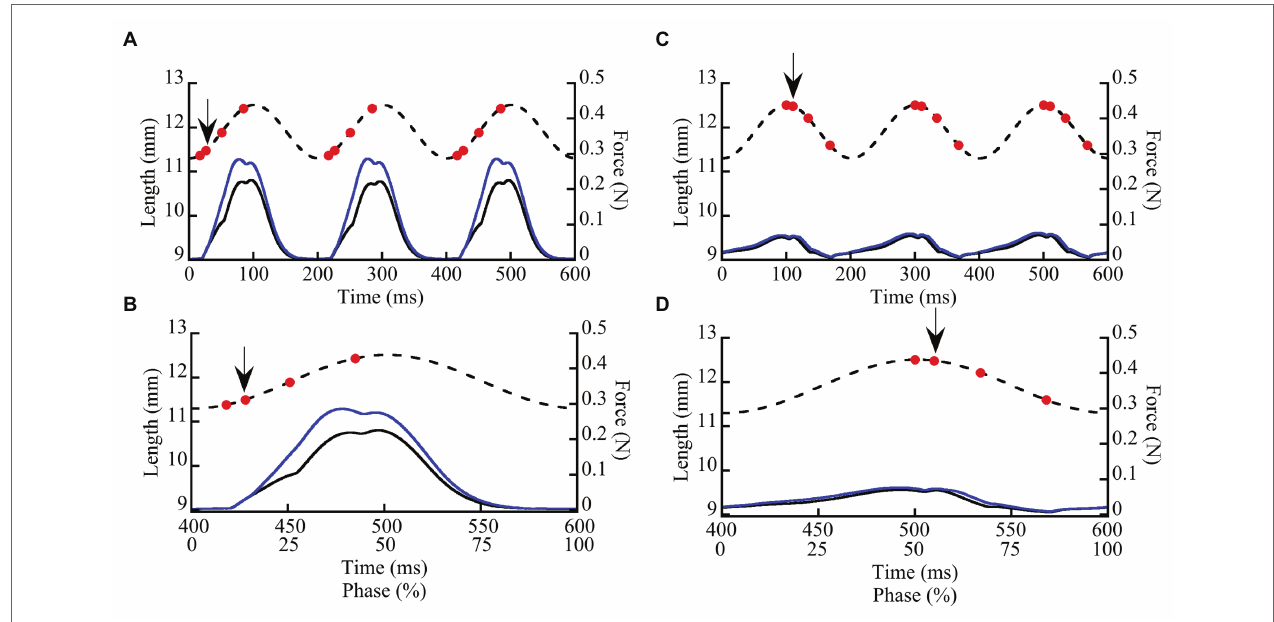
FIGURE 1 | Representative stretch-shortening cycles (SSCs) from whole wild type soleus muscles stimulated at two phases of activation (8.3 and 50%). Muscles were subjected to 3–4 SSCs at strain amplitude of ±5% L 0 and a frequency of 5 Hz (200 ms/cycle). In this example, a muscle was stimulated at a phase of 8.3% (A,B) when the muscle was lengthening and at a phase of 50% (C,D) at the onset of muscle shortening. (A,C) illustrate three successive cycles. (B,D) show the third cycle from each trial, as well as the relationship between time (ms) and phase (0–100%). Dashed lines show length vs. time and solid lines show force vs. time. Muscle force (solid lines) is shown for SSCs with (blue lines) and without (black lines) a doublet stimulus added 10 ms after the first stimulus in each cycle. Red dots indicate individual stimuli, the arrow indicates the